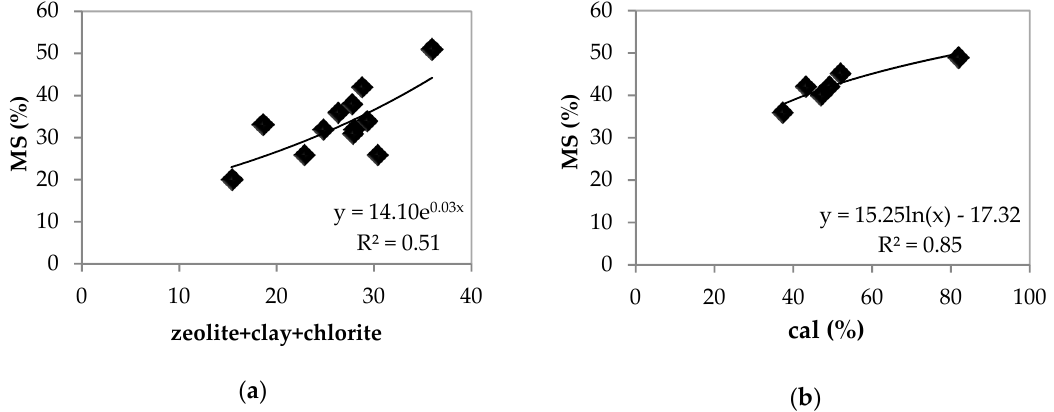
Figure 4. ( a ) Correlation between phyllosilicate and zeolite minerals and magnesium sulphate soundness coefficient (MS) for diabasic/basaltic aggregates; ( b ) correlation between calcite (cal) and magnesium sulphate soundness coefficient (MS) for calcarenite limestone aggregates.